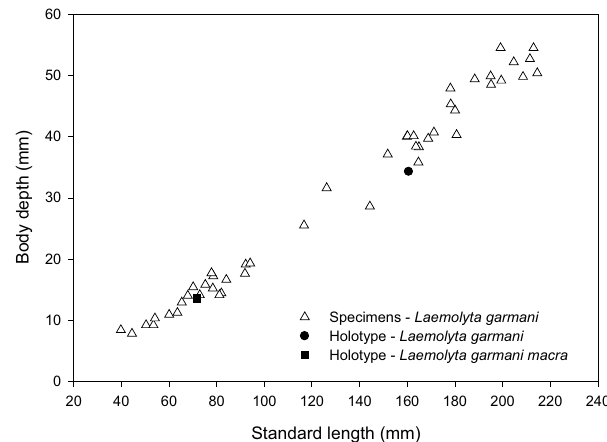
Fig. 15. Scatter plot of body depth on standard length for specimens and holotypes Laemolyta